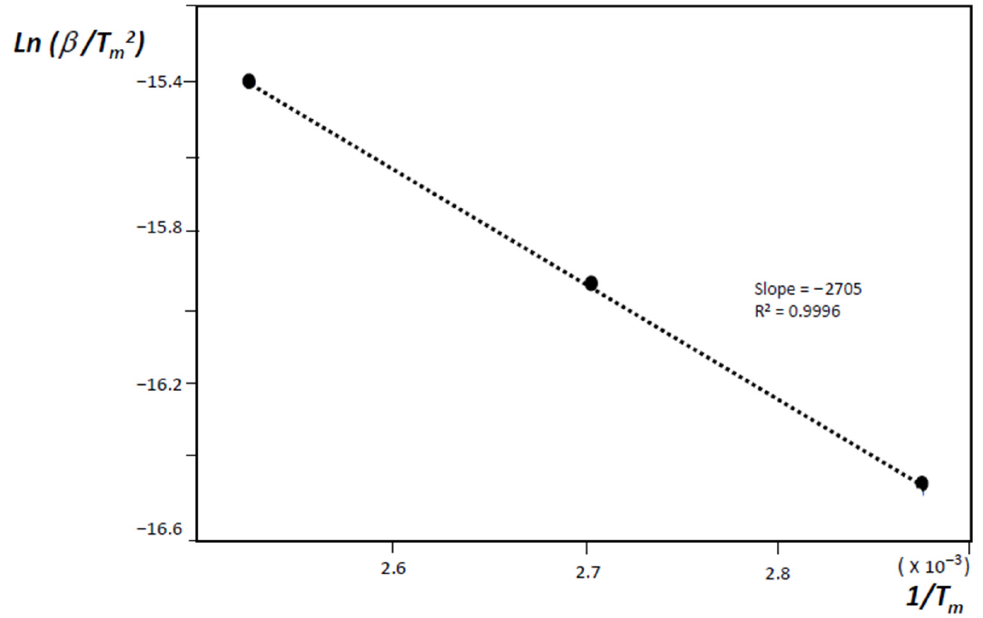
Figure 7. Fitting of a linear plot to the experimental points ( β i , T mi ) obtained for hydrogenated MWNT thread.